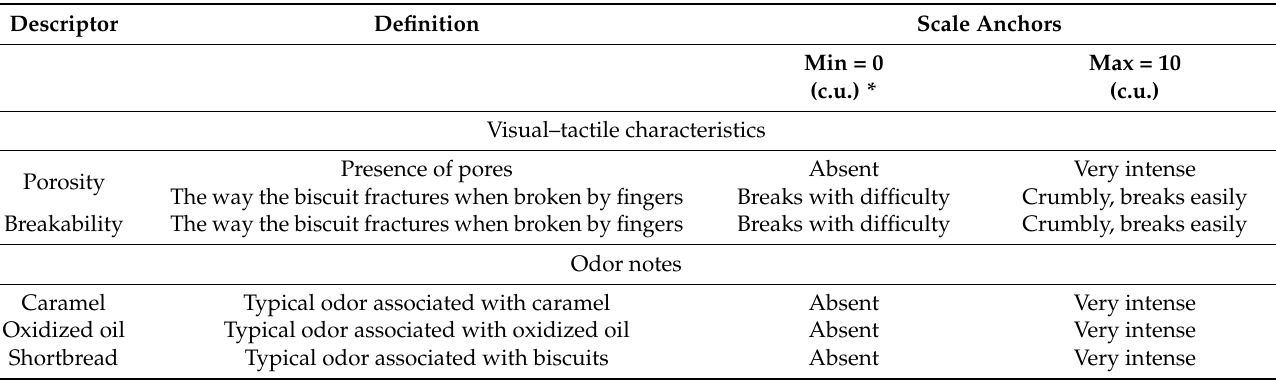
Table 2. Descriptive terms used for the sensory profiling of